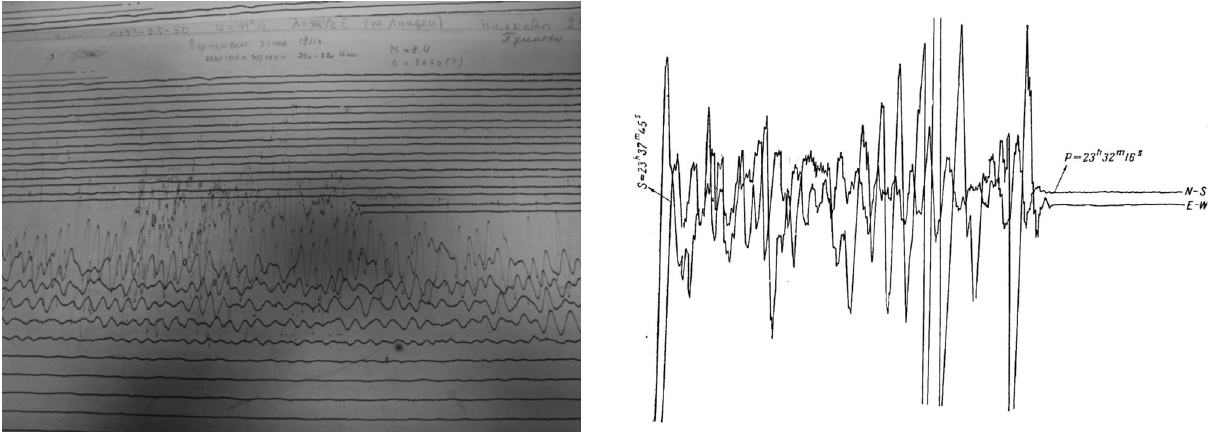
Figure 9. The record of Kemin earthquake at Pyulkovo seismic station (courtesy of Z.A. Kalmetyev).